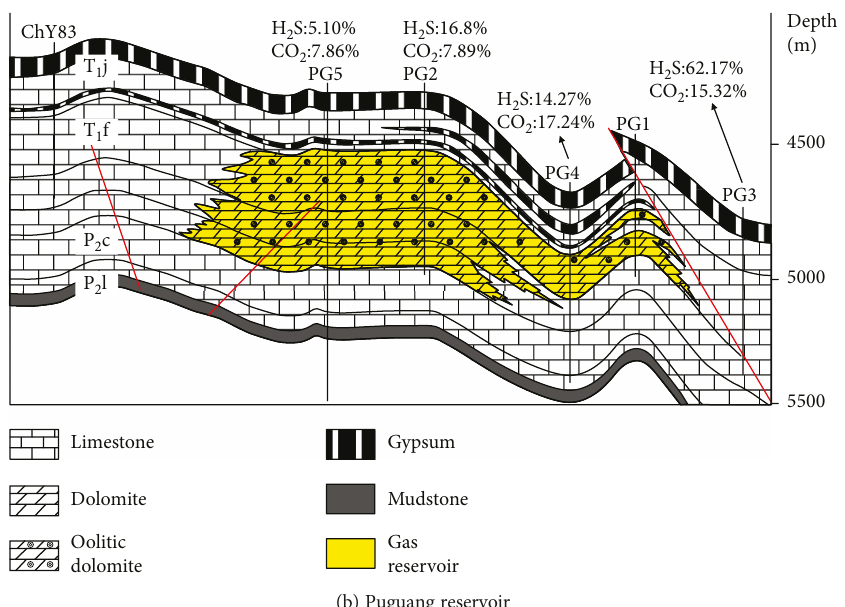
Figure 11: The Triassic Feixianguan Formation dolomite reservoir pro fi le a ff ected by deep burial-TSR-derived fl uid in the Puguang gas fi eld, Sichuan Basin. (a) Burial history (modi fi ed from Liu et al. [12]). (b) Gas reservoir pro fi le (modi fi ed from Ma et al.